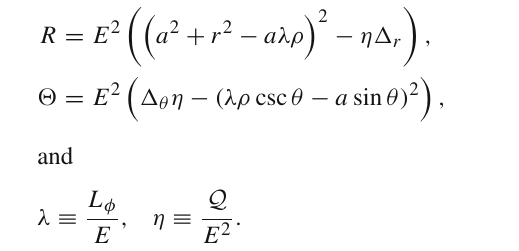
of rotating Kerr(-de Sitter) black holes for selected spin parameters for distant observers. b Shadows of rotating Kerr–de Sitter black holes for observers located at r =